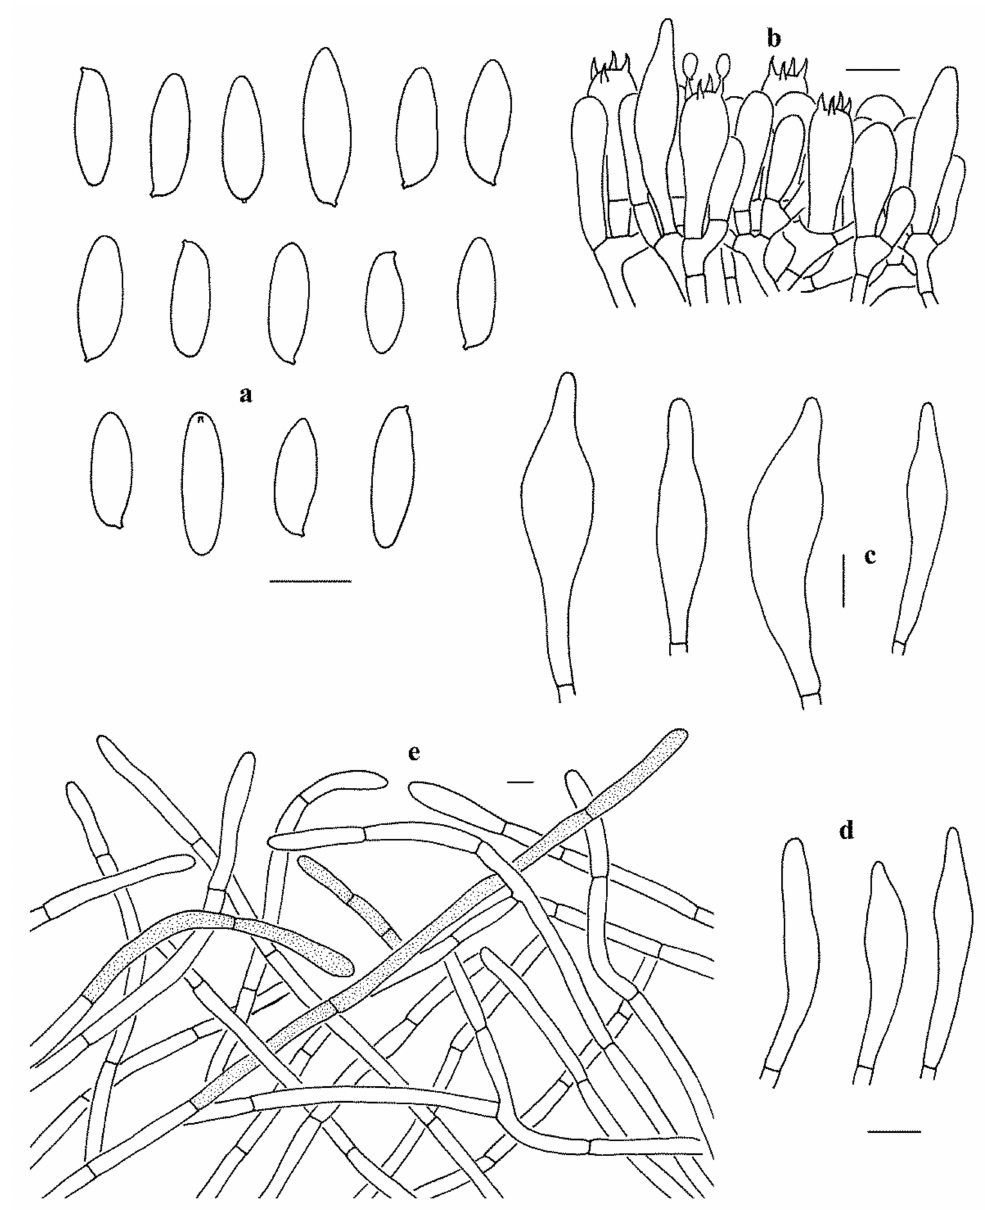
Figure 6. Microscopic features of Leccinum pseudoborneense (KUN-HKAS110156, holotype). ( a ) Basidiospores. ( b ) Basidia and pleurocystidia. ( c ) Pleurocystidia. ( d ) Cheilocystidia. ( e ) Pileipellis. Bars = 10 µ m. Drawings by Y.-C.